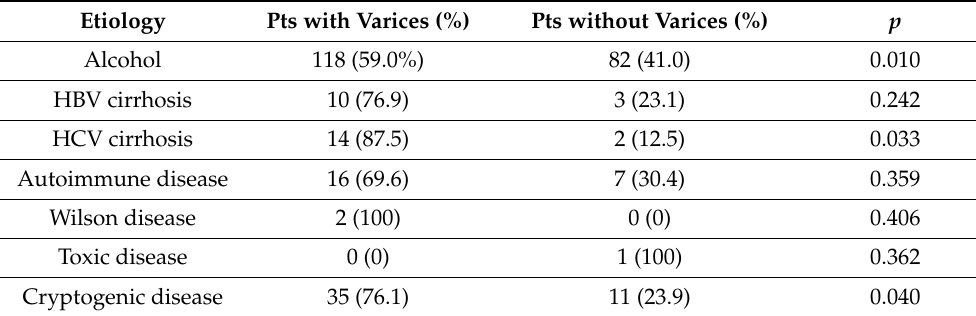
Table 4. The presence of esophageal varices in relation to the etiology of